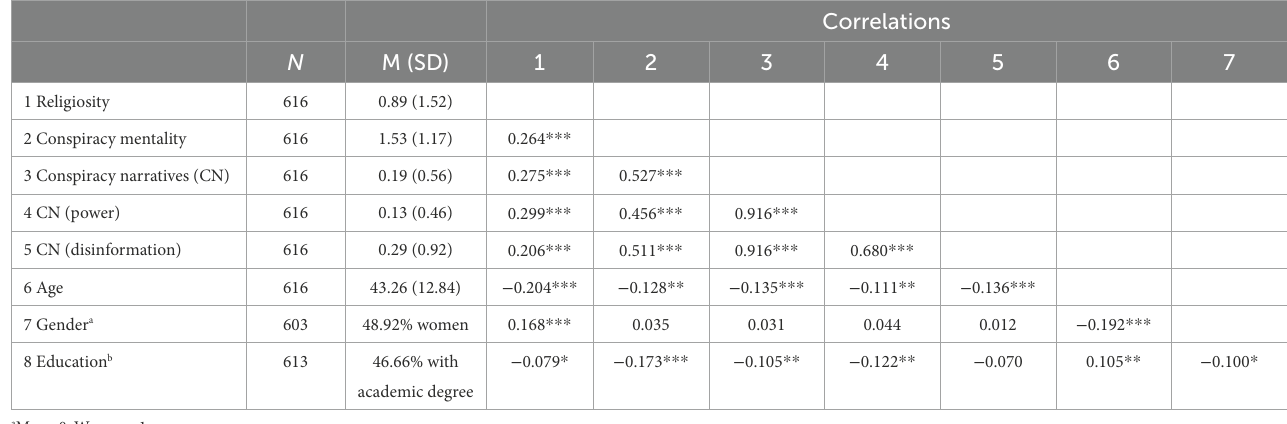
TABLE 1 Means of and correlations between constructs and socio-demographic